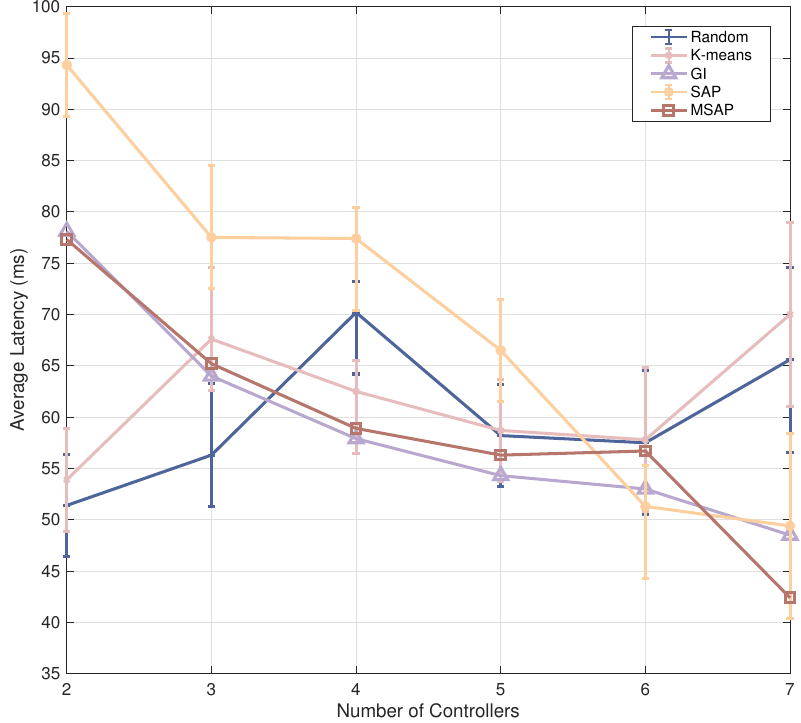
Figure 9. Latency for each control link in the LEO satellite